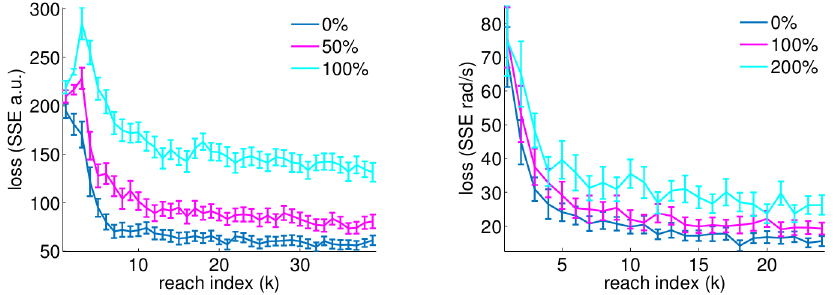
Fig 7. Plots depict decline in performance (i.e. loss between noise-free oracle and decoded intention) with intention noise model mismatch using sum square error (SSE) over the duration of a reach for (left) cursor task and (right) arm reaching task trajectories, comparable to performance curves in Figs 2 and 4 respectively. In each task, noise performance curves are obtained when the user ’ s intent is a noisy version of the oracle, captured by a linear combination of intention oracle and a random vector. The noise level is indicated by a noise percentage, corresponding to the magnitude of the noise relative to the intention oracle signal. The effects of the relative noise are not directly comparable across tasks because the noise is distributed over more dimensions in the arm